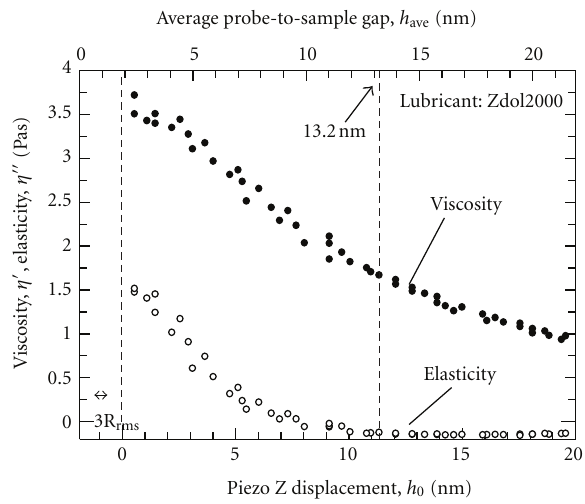
Figure 8: E ff ect of the shearing gap on the viscosity η (cid:4) and elasticity η (cid:4)(cid:4) measured with the Zdol2000 lubricant [24].